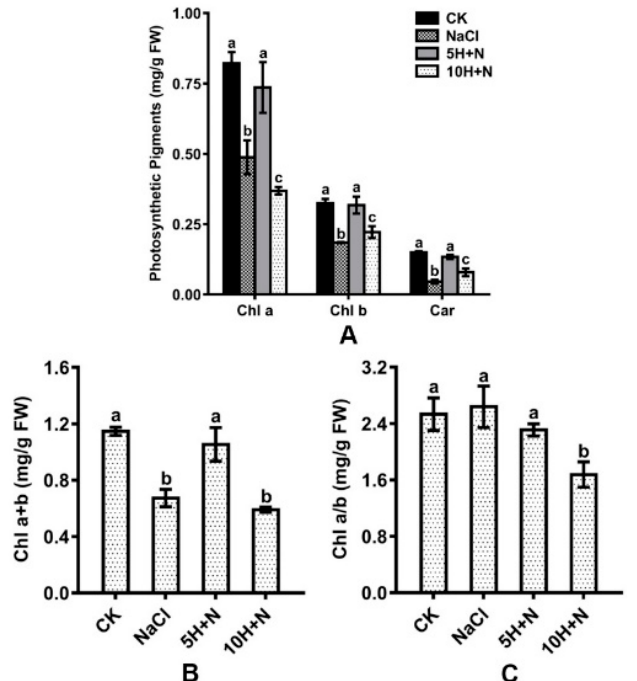
Figure 4. Effects of exogenous H 2 O 2 on Chl a, Chl b, and Car ( A ), Chl a + b ( B ), and Chl a/b ( C ) of Tartary buckwheat under NaCl stress. CK: control, H 2 O foliar spray + H 2 O irrigation, NaCl: H 2 O foliar spray + 150 mmol · L − 1 NaCl irrigation, 5H + N: 5 mmol · L − 1 H 2 O 2 foliar spray + 150 mmol · L − 1 NaCl irrigation, 10H + N: 10 mmol · L − 1 H 2 O 2 foliar spray + 150 mmol · L − 1 NaCl irrigation. Chl a: chlorophyll a (mg/g FW), chlorophyll b (mg/g FW), Car (mg/g FW). All values are expressed as mean ±